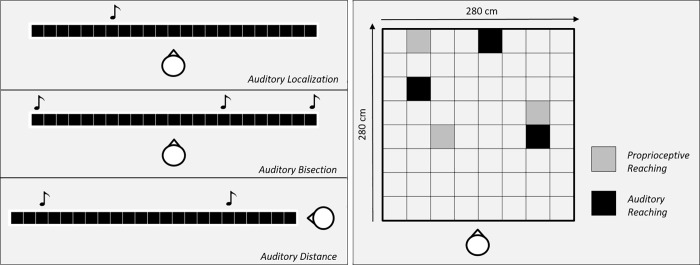
Representative description of five out of six tasks included in the BSP (Blind Spatial Perception) battery.In the left panel, the three tasks illustrated (auditory localization, auditory bisection and auditory distance) share the same experimental setup made of 23 loudspeakers embedded in a fixed array and positioned at a distance of 180 cm from the participant. In the right panel, the two tasks illustrated (auditory reaching and proprioceptive reaching) share the same experimental setup made of a carpet with a central square marked on the floor with colored tape (280 x 280 cm) on which specific positions were selected in order to perform the tasks.